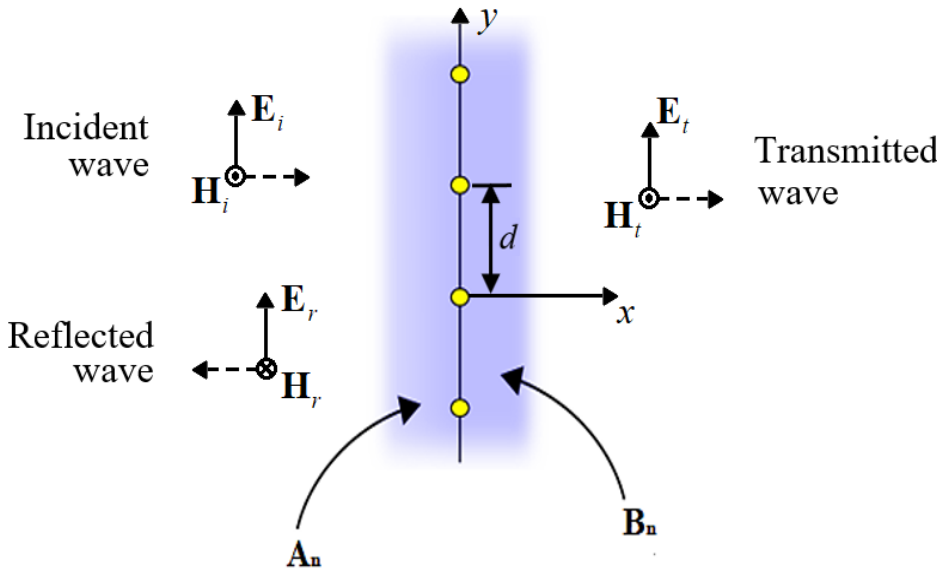
Figure 3. Reflection and transmission from an array of wires.